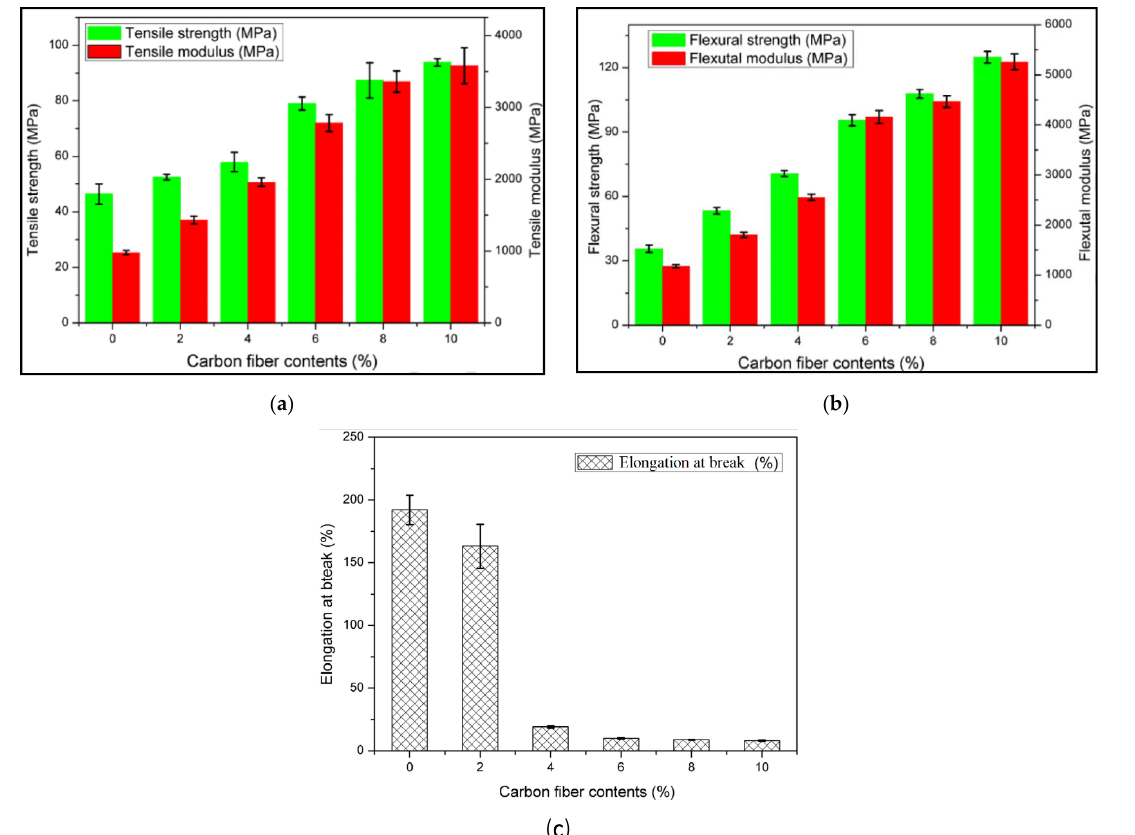
Figure 16. Effect of increasing fiber content % wt: ( a ) tensile modulus and strength; ( b ) flexural modulus and strength; ( c ) elongation at break (%) [66] (reprinted with kind permission from Elsevier).